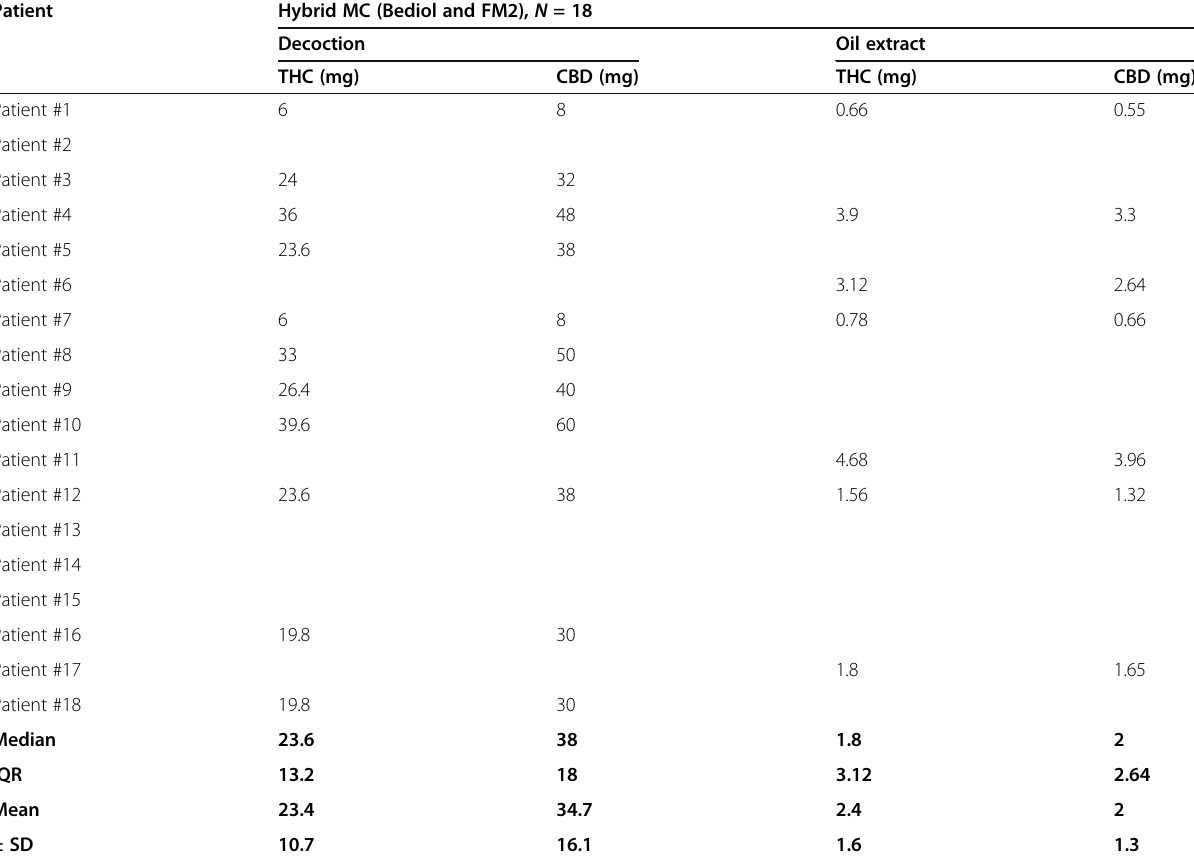
Table 12 Dosage of THC and CBD administered with hybrid medical cannabis to Italian fibromyalgia patients for at least 3 months